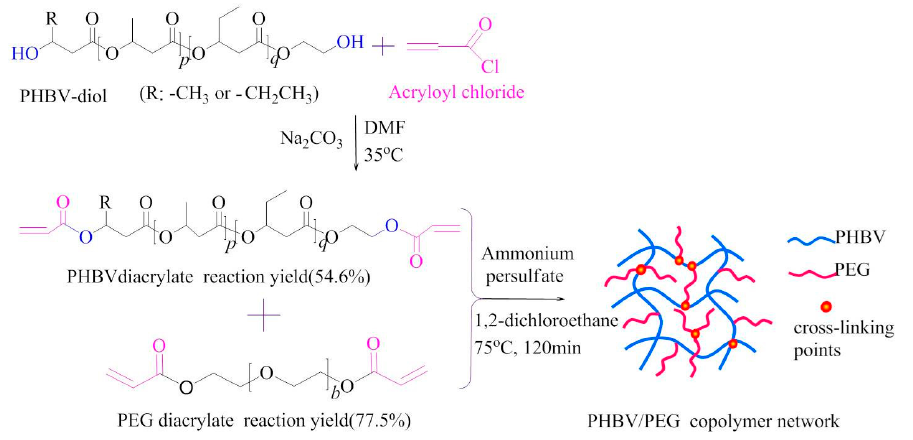
Figure 7. Synthesis of PHBHV/PEG copolymer network. Reprinted with permission from